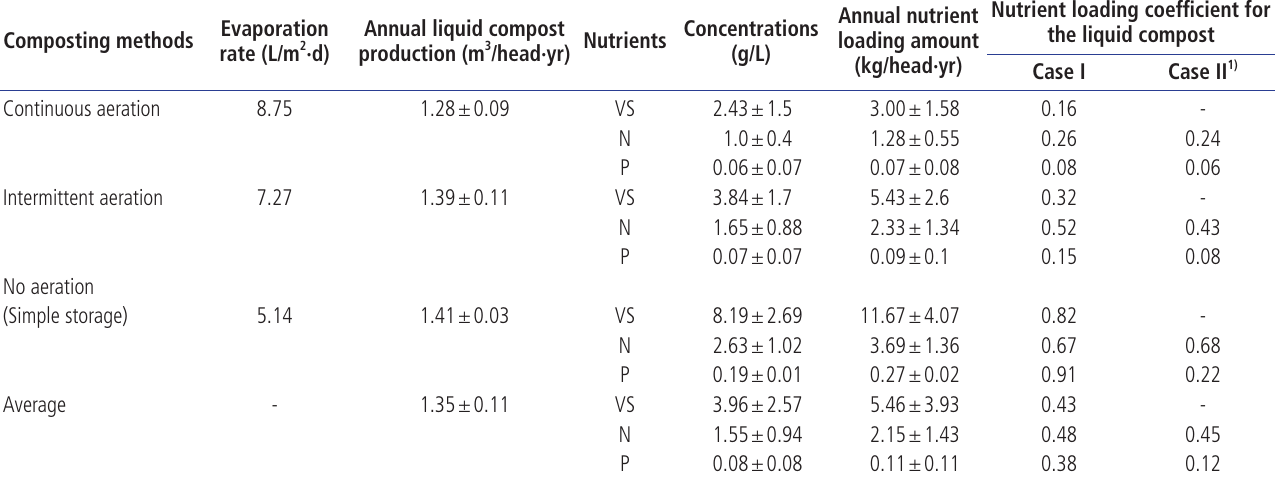
Table 7. The amount and characteristics of liquid compost produced with evaporation rate and nutrient loading coefficients Composting